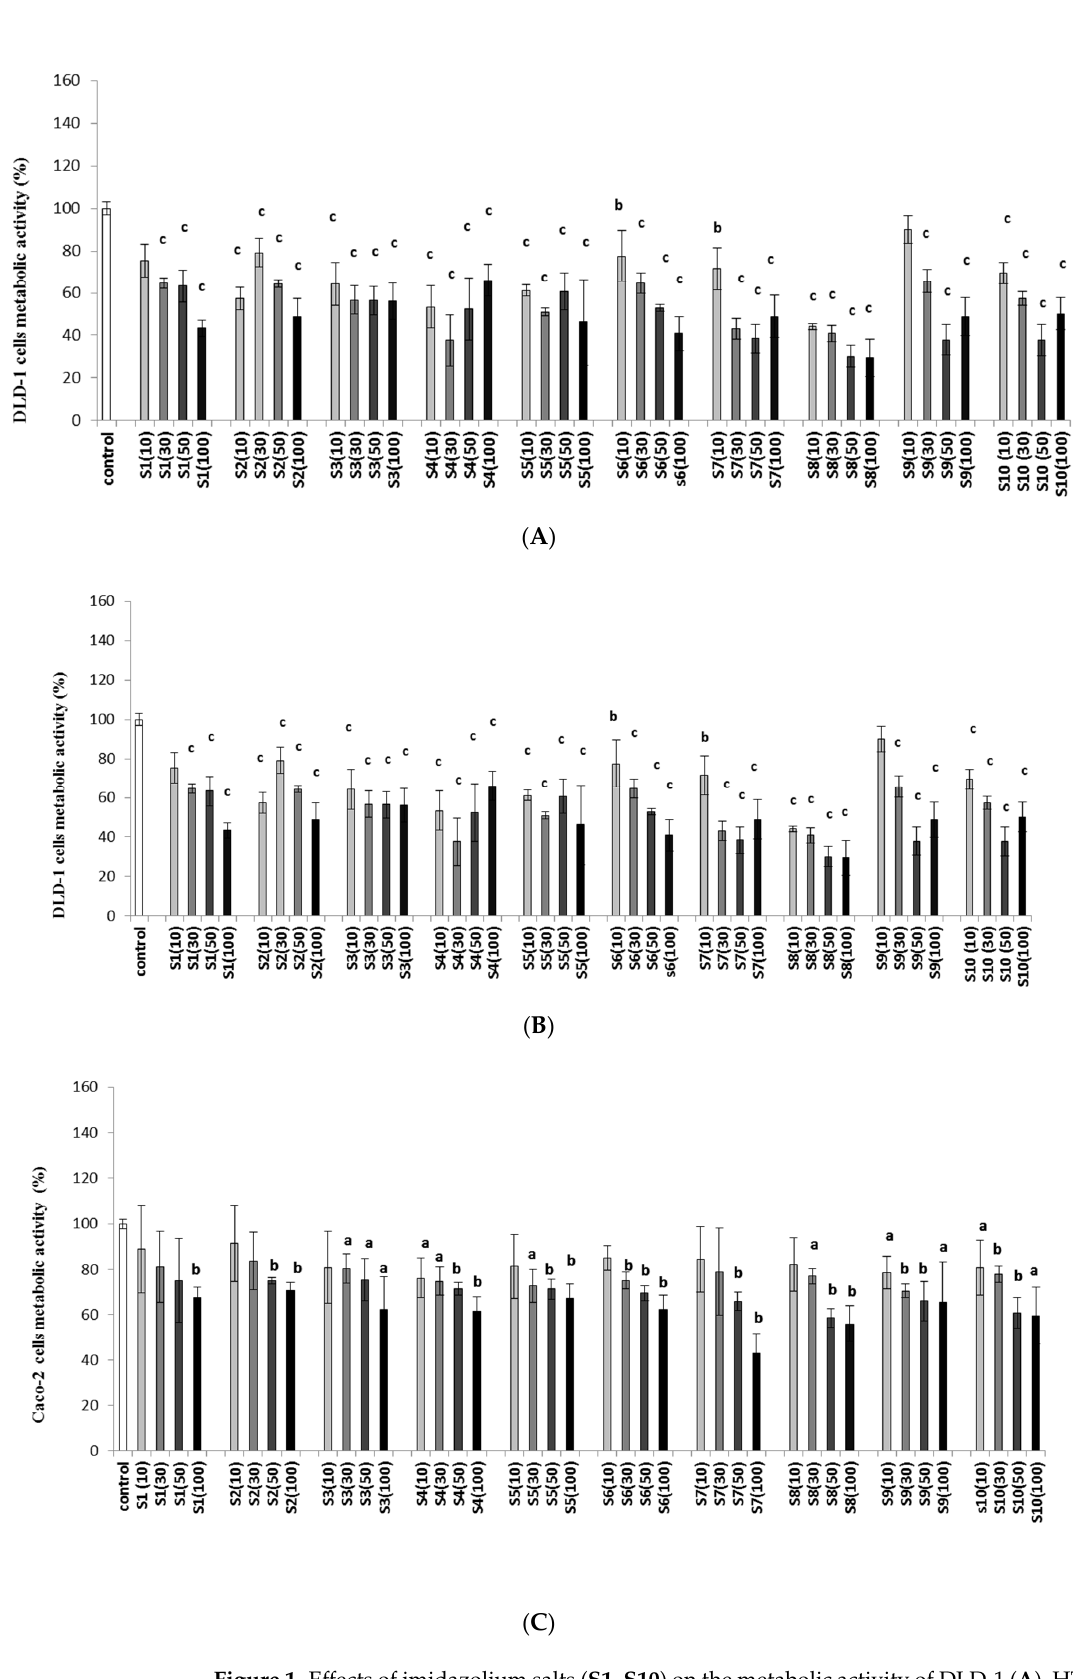
Figure 1. Effects of imidazolium salts ( S1 – S10 ) on the metabolic activity of DLD-1 ( A ), HT-29 ( B ), and Caco-2 ( C ) cells after 24 h of incubation. Concentrations (µg/mL) are given in parentheses. The results are presented as the mean values ± SD. a p < 0.05, b p < 0.01, and c p < 0.001, compared with the